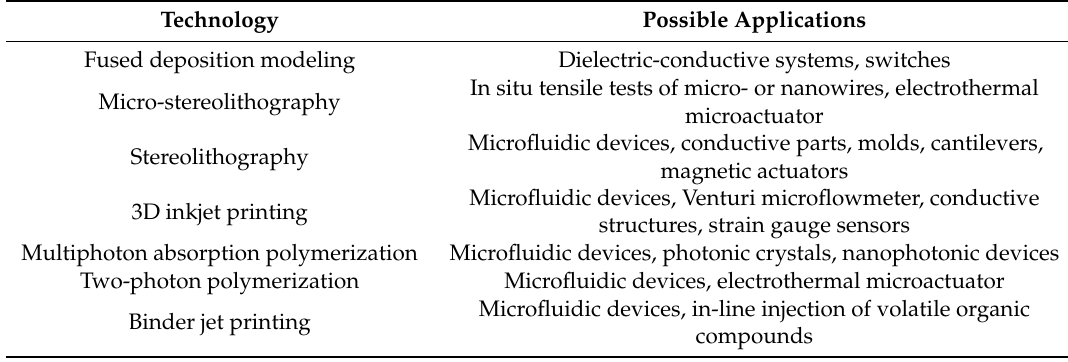
Table 2. Possible applications of typical 3D printing technologies used for